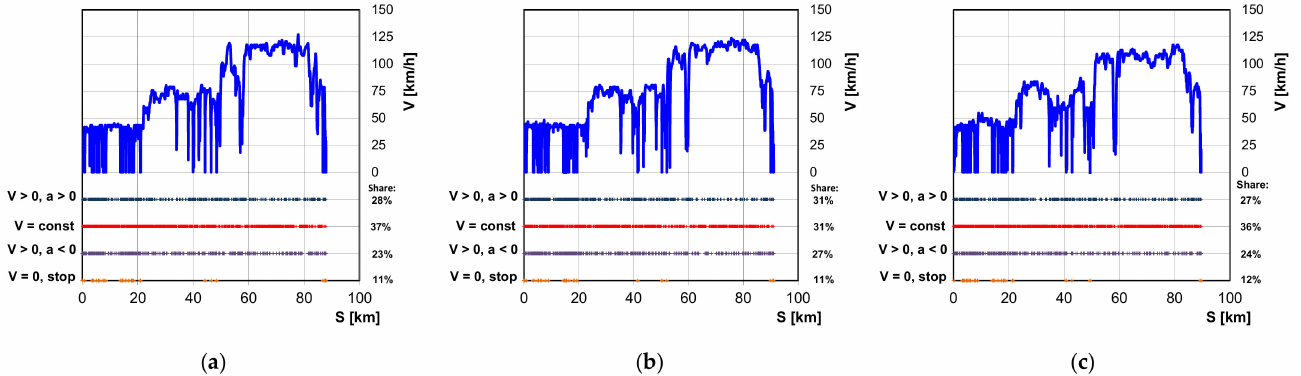
Figure 3. Characteristics of speed in passenger vehicles with a spark ignition engine ( a ), diesel engine ( b ), PHEV ( c ), in RDE tests with the marked shares of acceleration, constant speed, braking and